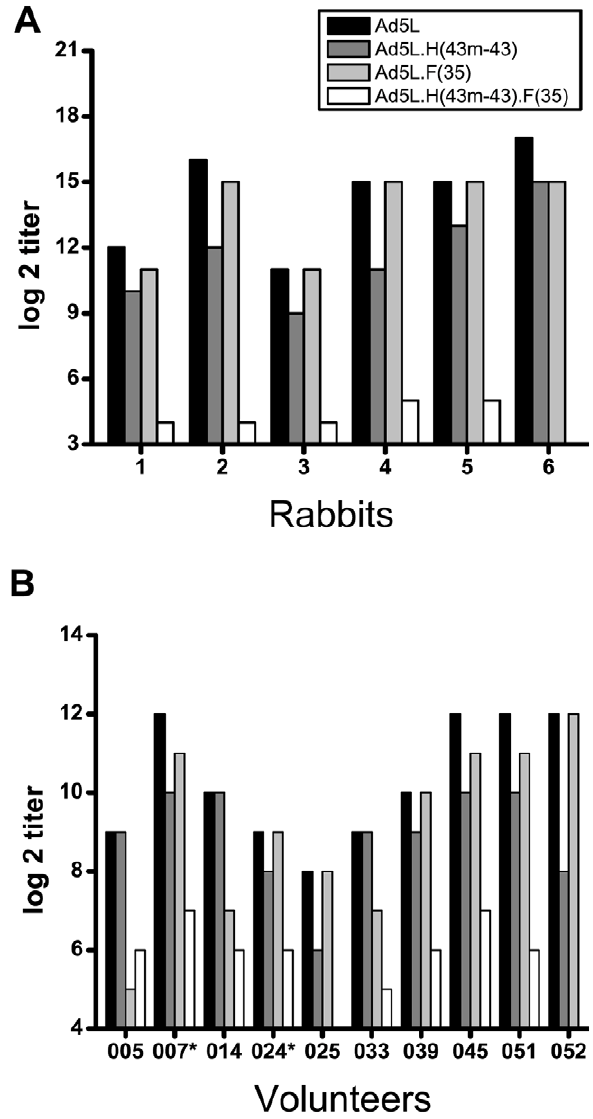
Figure 4. NAb directed at both HVRs and fiber are dominant in vitro . Sera from (A) rabbits immunized with two administrations of 1 6 10 10 pu of AdNull or (B) human volunteers screened for the presence of neutralizing antibodies specific for Ad5 were analyzed for NAb titers against a panel of chimeric adenovectors expressing the luciferase reporter gene. Ad5L is an unmodified Ad5 vector; Ad5L.H(43 m-43) is a hexon-modified Ad5 vector containing HVRs 1–9 from Ad43; Ad5L.F35 is an Ad5 vector carrying the Ad35 fiber; Ad5L.H(43 m-43).F35 is a hexon-modified vector carrying the Ad35 fiber. The asterisk indicates serum samples that scored positive for Ad35-specific